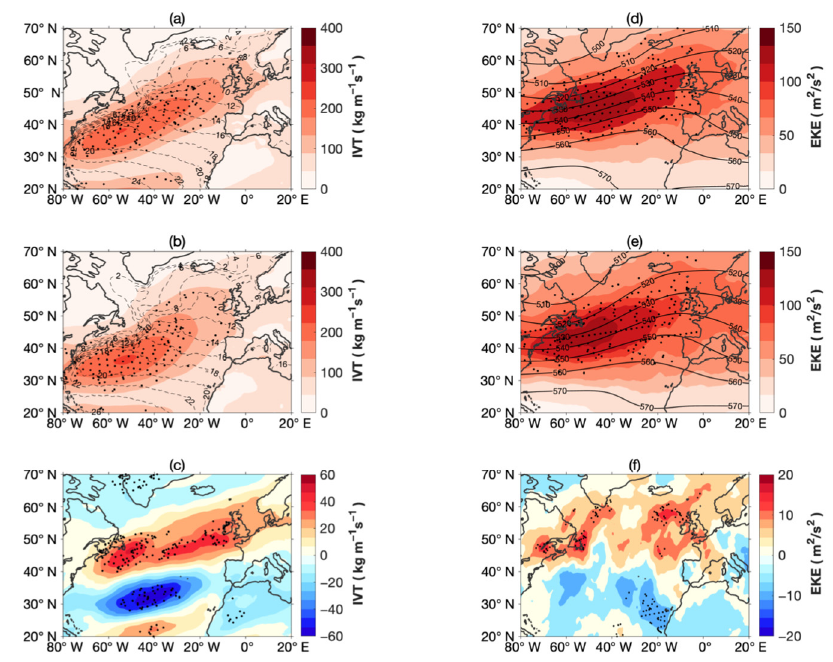
Figure 3. ( a ) Distribution of IVT (colors, kg m − 1 s − 1 ) and mean SSTs (contours, ◦ C) in NAT+ phase. ( b ) IVT (color) and SSTs (contour) in NAT − phase. ( c ) Difference in IVT (color) in NAT+ and NAT − phases. Black dots mark those above 95% confidence level based on a Student’s t -test. Right column ( d – f ) is same as the left but for EKE(m 2 /s 2 ) on 300 hPa and contours are Z500 (10 m).